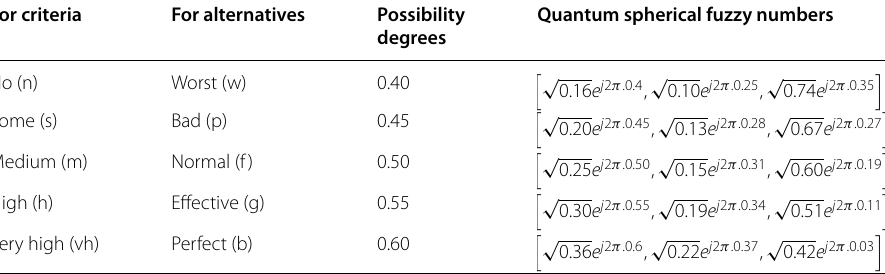
Table 2 Linguistic scales and golden cut-based quantum spherical fuzzy numbers For criteria For